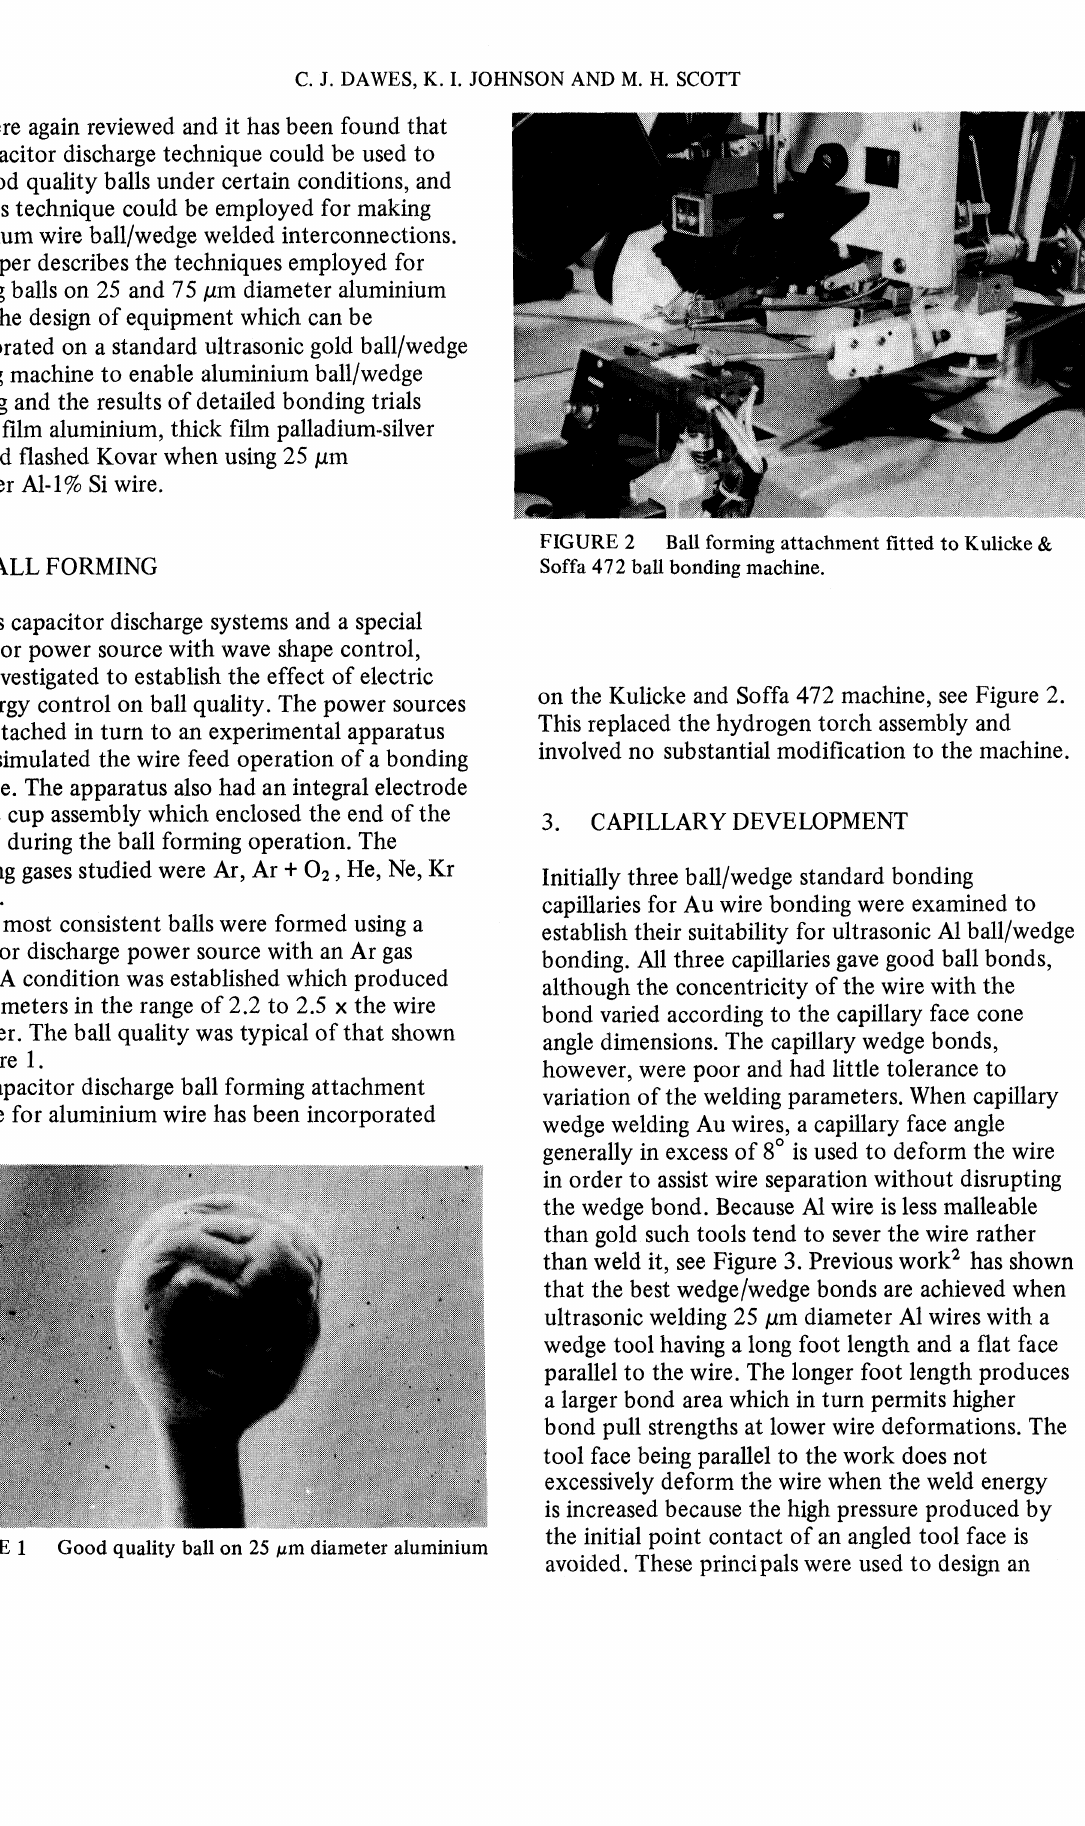
Good quality ball on 25 m diameter aluminium